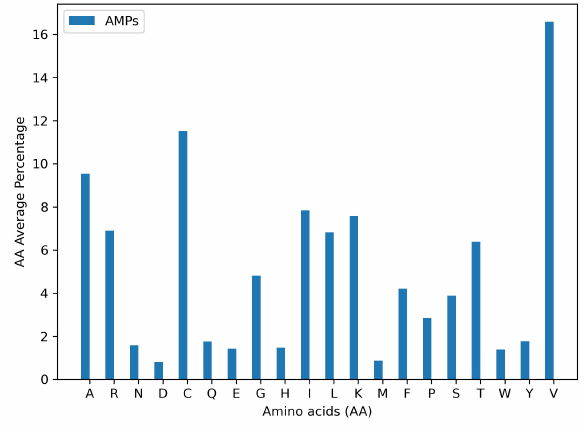
Figure 5. Average percentage of each amino acid within all sequences of predicted